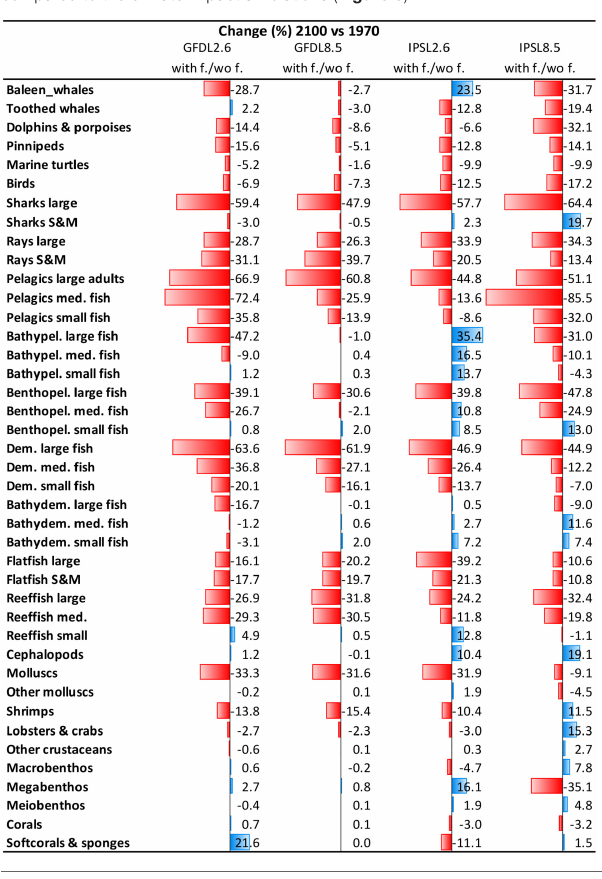
TABLE 4 | Comparison of Experiment 2 (Climate impacts) and 3 (Climate and fishing impacts) ( Table 1 )—Temporal Change (%) of biomass by functional